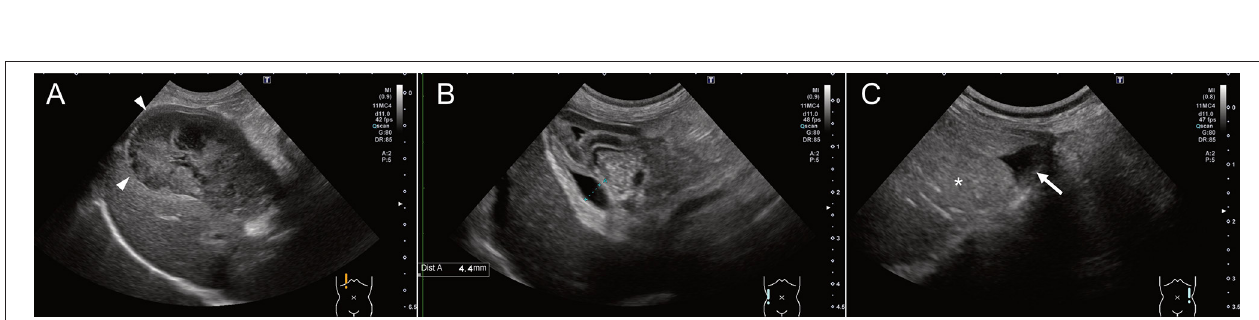
FIGURE 2 | Ultrasonographic findings. (A) The gallbladder showed a kiwi-like pattern and stella combination with residual central echogenic bile (white arrow-head), indicating gallbladder mucocele. (B) The common biliary duct dilation without echogenic sediment or debris was observed (4.4mm). (C) A small amount of ascites (white arrow) was detected around the spleen